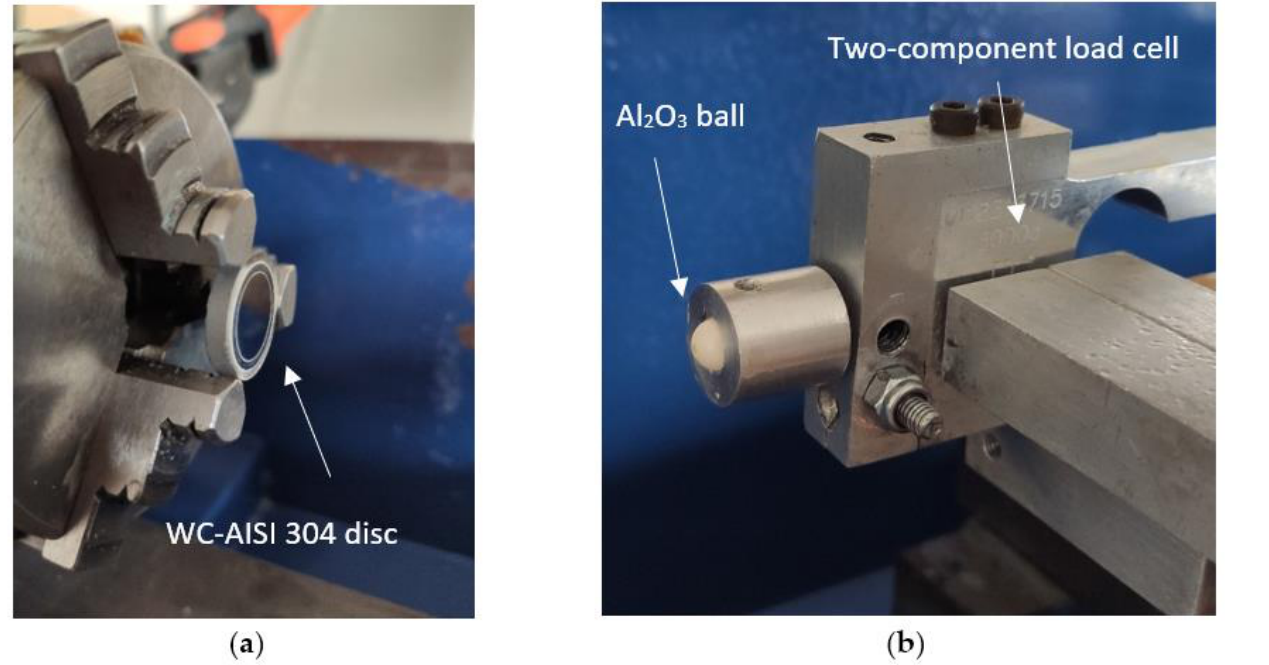
Figure 6. Mechanism for fixing the disks to the tribometer ( a ). Mounting the conical support for fixing the counter body on the tribometer ( b ).